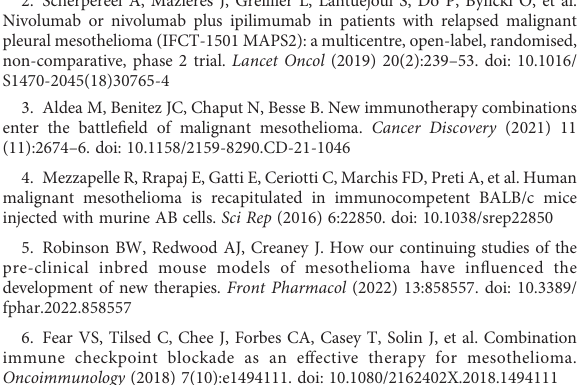
Table S1.2 Panel of antibodies. Table S1.3 Compensation matrix. SUPPLEMENTARY TABLE 2 List of primers. SUPPLEMENTARY TABLE 3 Signal pathways enrichment analysis in AB12 tumors. Table S3.1